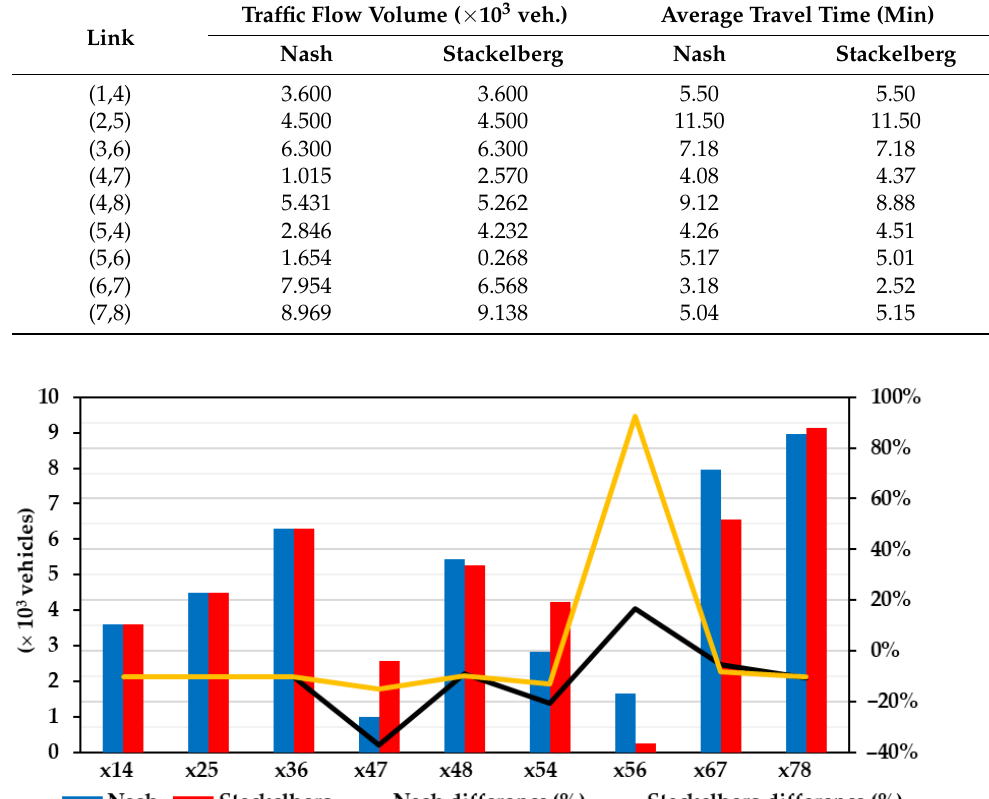
Figure 7. Traffic volume compared in individual links to road network for scenario #2. (Nash and Figure 7. This is a figure. Schemes follow the same formatting. If there are multiple panels, they Stackelberg differences (%) represent the percentage increase in traffic volumes on each link compared should be listed as: ( a ) Description of what is contained in the first panel. ( b ) Description of what is to the results of scenario contained in the second panel. Figures should be placed in the main text near to the first time they are cited. A caption on a single line should be centered.